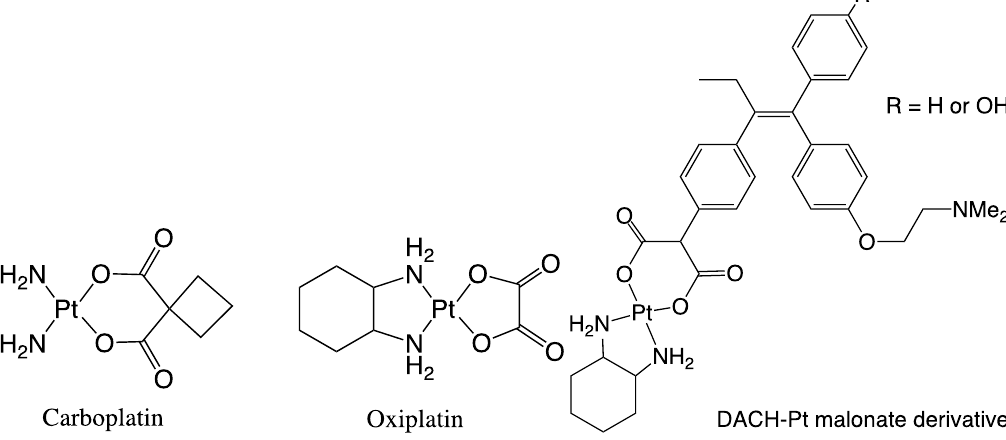
Figure 3. Example of a coordination compound containing Pt(II) used in the screening for anti- cancer